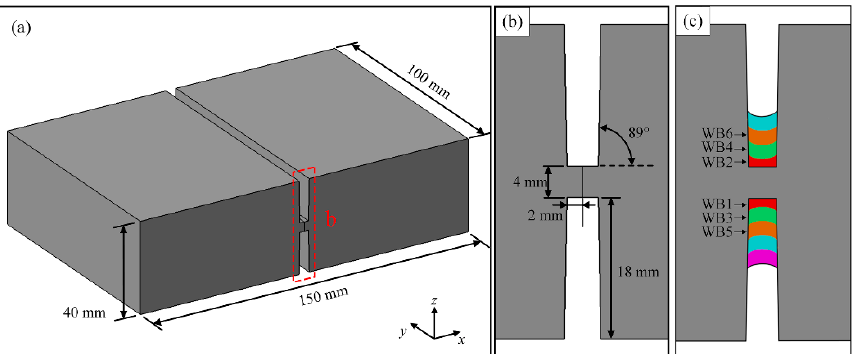
Figure 1. The schematic diagram of weldment: ( a , b ) the geometric dimension of 40 mm-thick Ti-6Al-4V alloy plates, ( c ) the welding sequence.